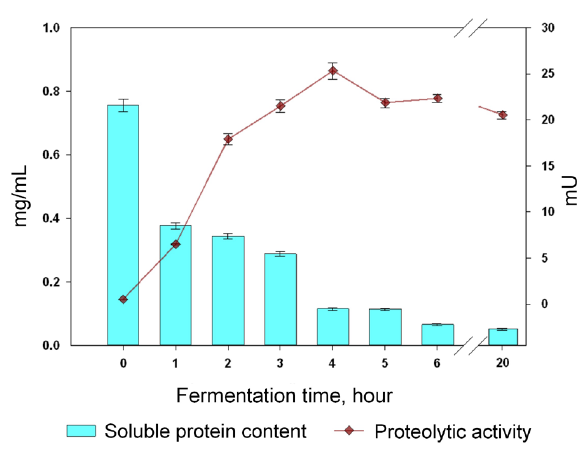
Fig. 2. Dynamics of soluble protein content and proteolytic activity during fermentation